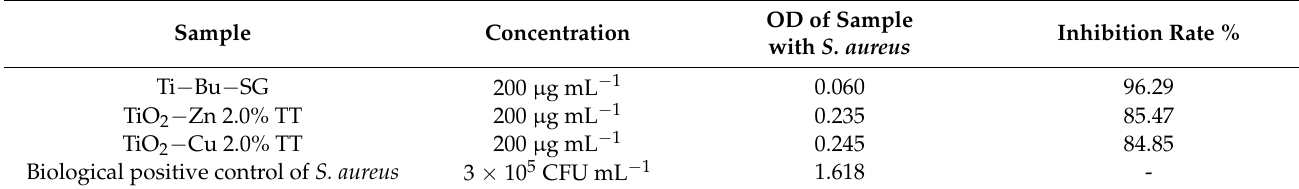
Table 5. Absorbance values for nanopowders in broth